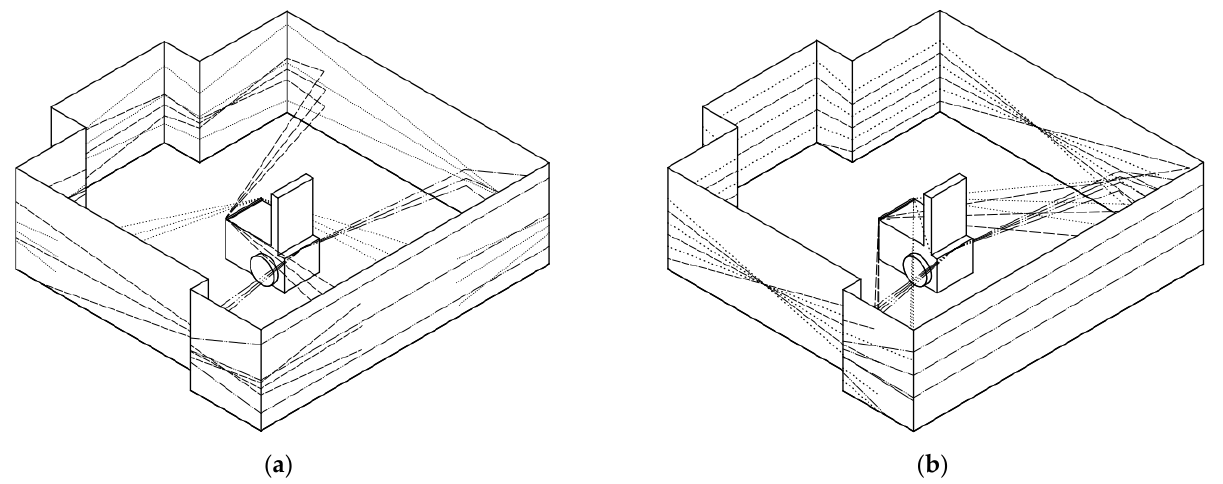
Figure 7. Arrangement of scanning devices in the wheelchair.